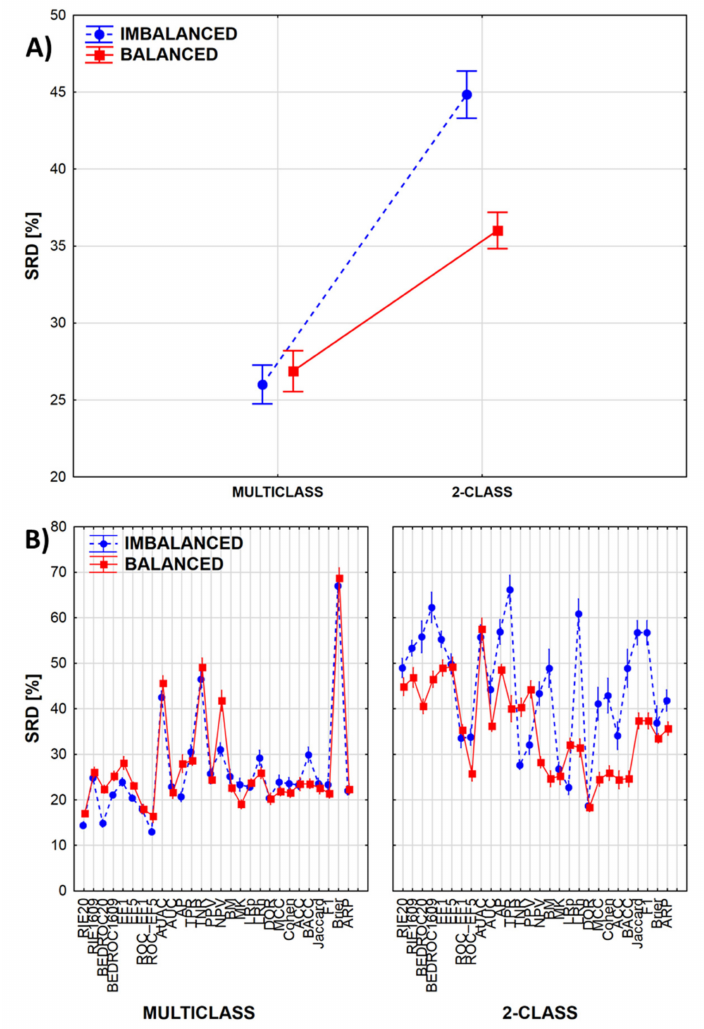
Figure 4. ( A ) SRD values are, on average, higher for 2-class classification scenarios (farther from the reference), meaning that there is a greater degree of disagreement between the performance metrics in this case, highlighting the importance for their informed selection and application during model evaluation. The di ff erence is even more pronounced if the dataset is imbalanced. ( B ) Most of the performance metrics are quite robust in multiclass scenarios, while in 2-class cases, the balanced or imbalanced datasets have a much greater e ff ect on model ranking. (Normalized SRD values are shown always on the Y axis. The markers denote average values, and the vertical lines denote 95% confidence